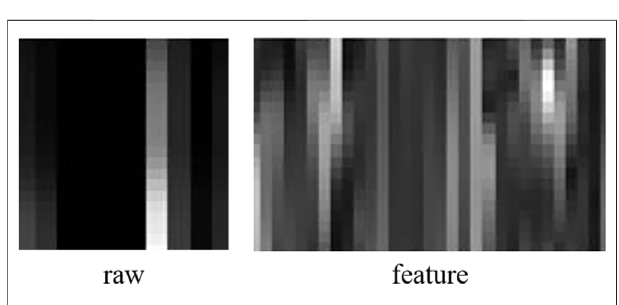
FIGURE 10 | Raw image and feature